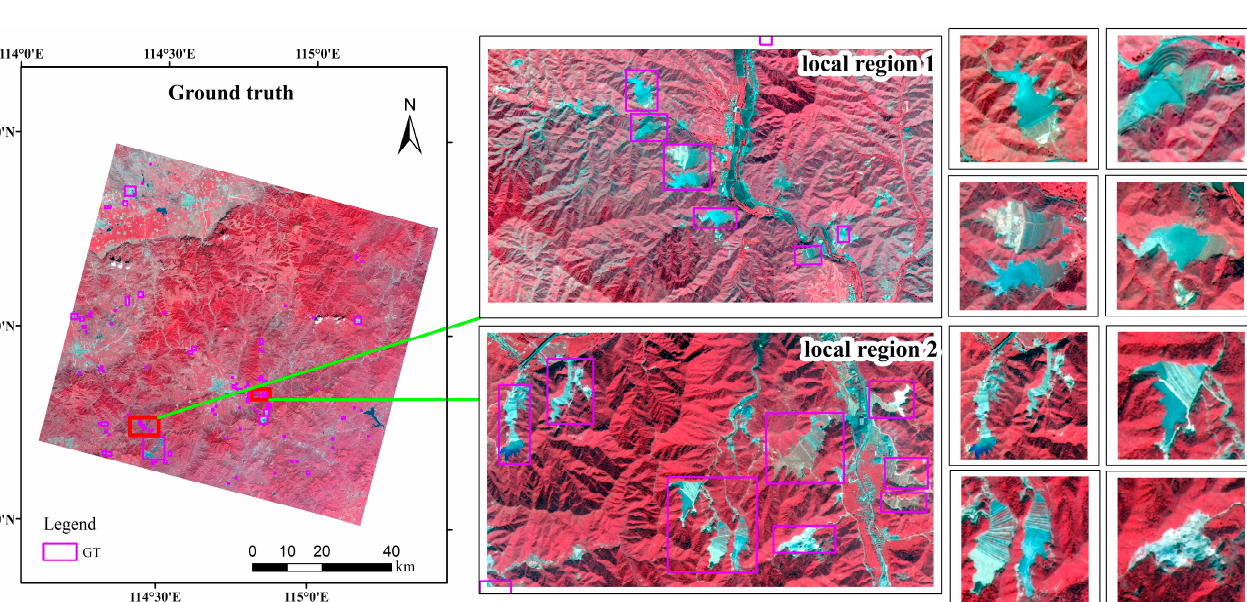
Figure 12. In fl uence curve of the IoU threshold on the accuracy of tailings ponds detection. Figure 12. Influence curve of the IoU threshold on the accuracy of tailings ponds detection.